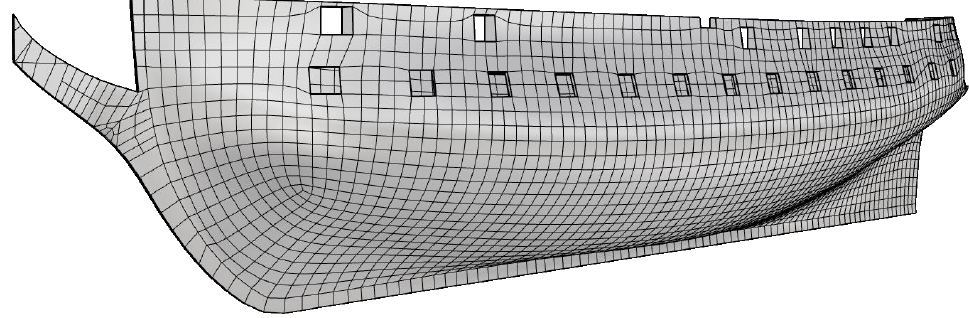
Figure 6 . Result of quad-remeshing the NURBS surfaces of Figure